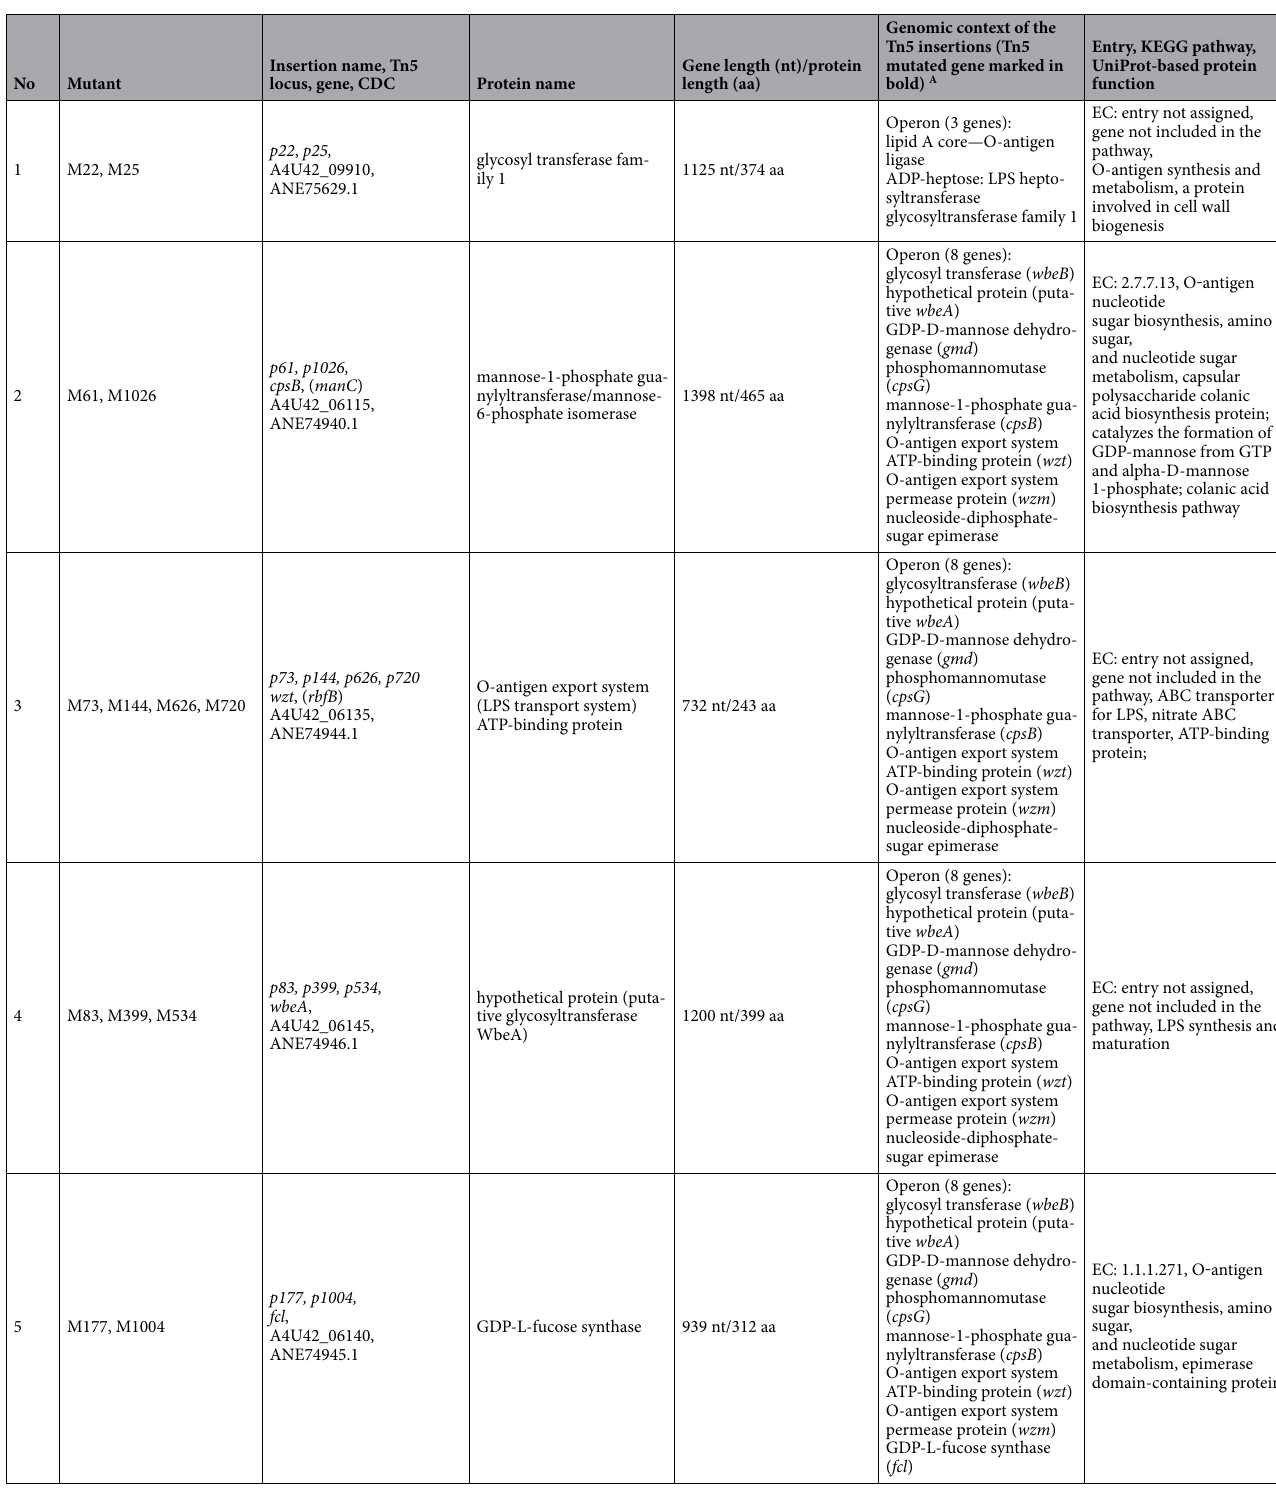
Table 1. Genetic loci of Dickeya solani strain IPO 2222 Tn5 mutants expressing resistance against phage vB_Dsol_D5 (ΦD5) . A Assessment of the transcriptional organization was predicted using Operon ‐